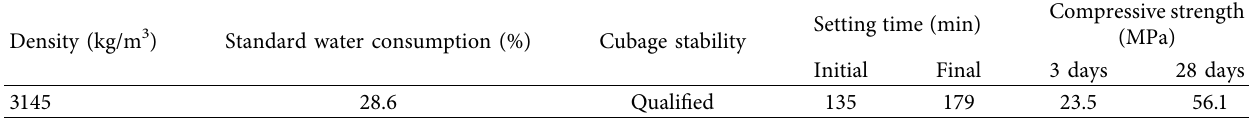
Table 3: Physical and mechanical properties of used cement.